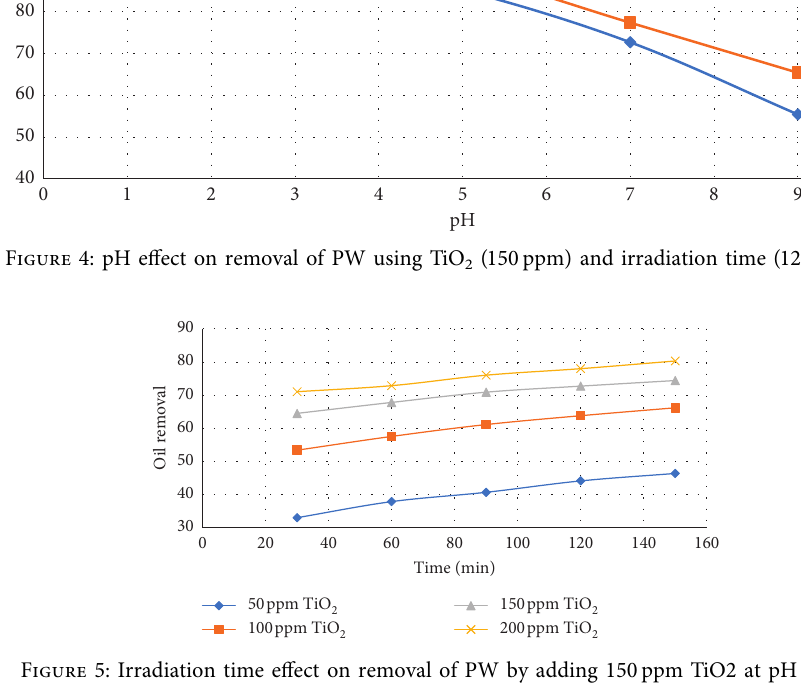
Figure 5: Irradiation time effect on removal of PW by adding 150ppm TiO2 at pH � 6.5.